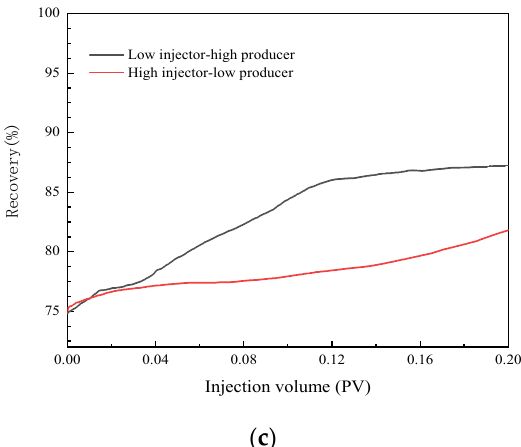
Figure 14. Production curves under different relationship: ( a ) water cut; ( b ) gas production rate; ( c ) cumulative recovery.